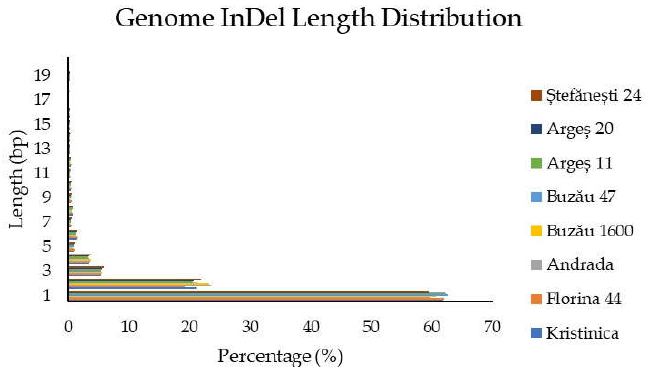
Figure 3. InDels distribution within the genome.